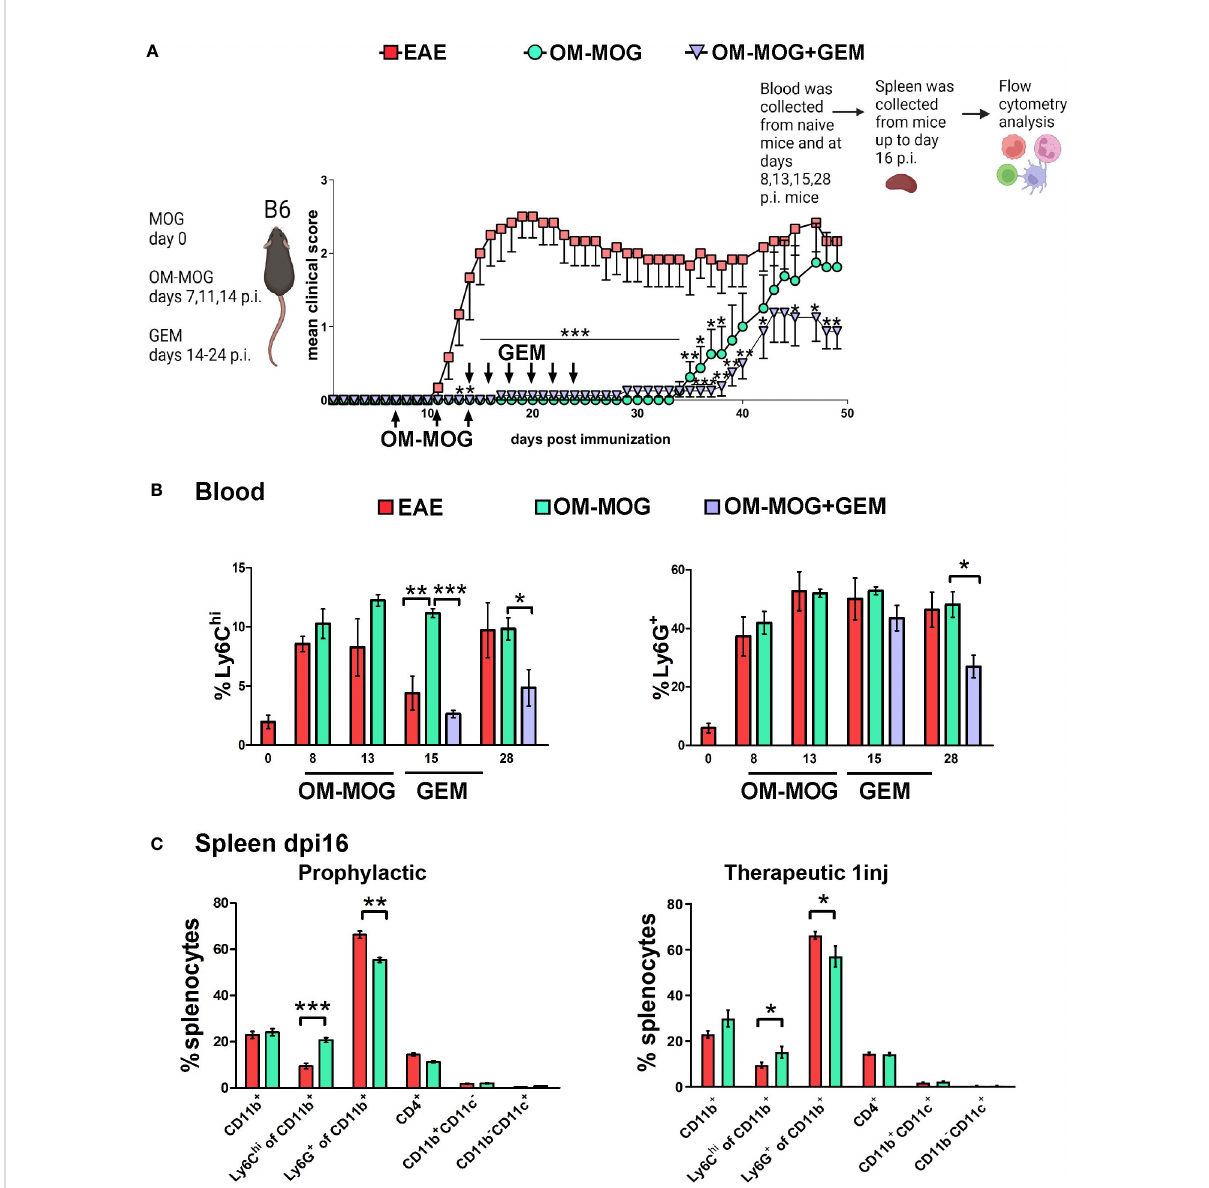
FIGURE 3 OM-MOG retains Ly6C hi monocytes in the periphery during the induction of EAE. (A) Schematic representation of the experimental approach and the time points of injection of OM-MOG and gemcitabine (GEM) in the EAE mice. Mean clinical scores of EAE mice after short-term prophylactic administration of OM-MOG (dpi 7, 11 and 14, upward arrows) and post-onset administration of GEM (dpi 14 and every 2 days, downward arrows) (n=6-8/group). (B) Time-course of Ly6C hi and Ly6G + cell expansion in blood of EAE mice untreated or treated with GEM, as shown in A (n= 3-4/ group/time-point). (C) Proportions of CD11b + , Ly6C hi , Ly6G + , CD11b + CD11c + (myeloid DC) and CD11b - CD11c + (DC) myeloid cells and CD4 + T cells in spleen of EAE mice after short-term prophylactic (as shown in A., left panel) or therapeutic (24 h post-injection, right panel) administration of vehicle or OM-MOG, at peak of disease in the vehicle mice (dpi 16) (n=8 for EAE and n=4 for OM-MOG). Data and statistical analysis are derived from one experiment in each case (one for A, B , one for C ). Statistical signi fi cance is shown after comparison to the vehicle (EAE) group using Mann-Whitney test (A) , one-way ANOVA followed by Tukey ’ s post hoc test (B) , or Student ’ s t test (C) (*p ≤ 0.05, **p ≤ 0.01, ***p ≤